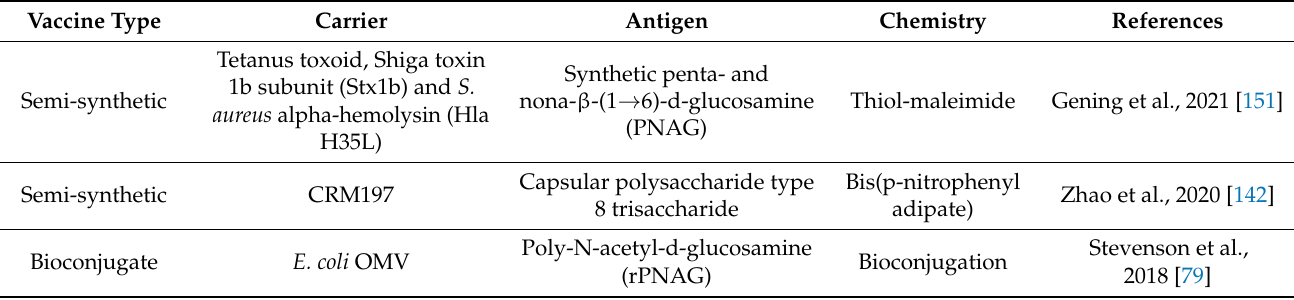
Table 9. Carbohydrate conjugate vaccines targeting Staphylococcus aureus